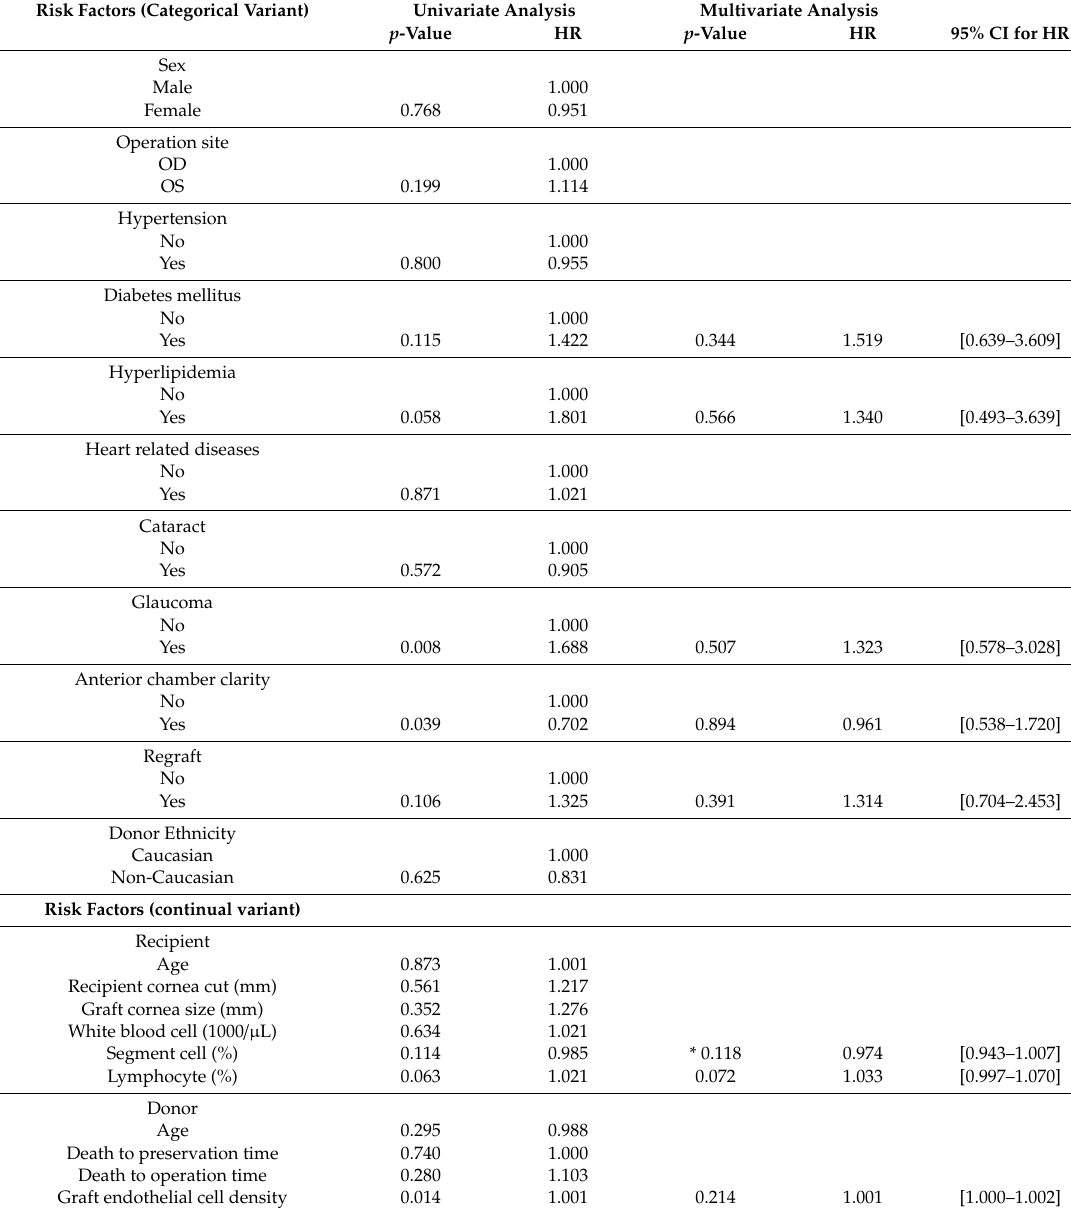
Table 4. Univariant and multivariant Cox regression analysis of risk factors of PK